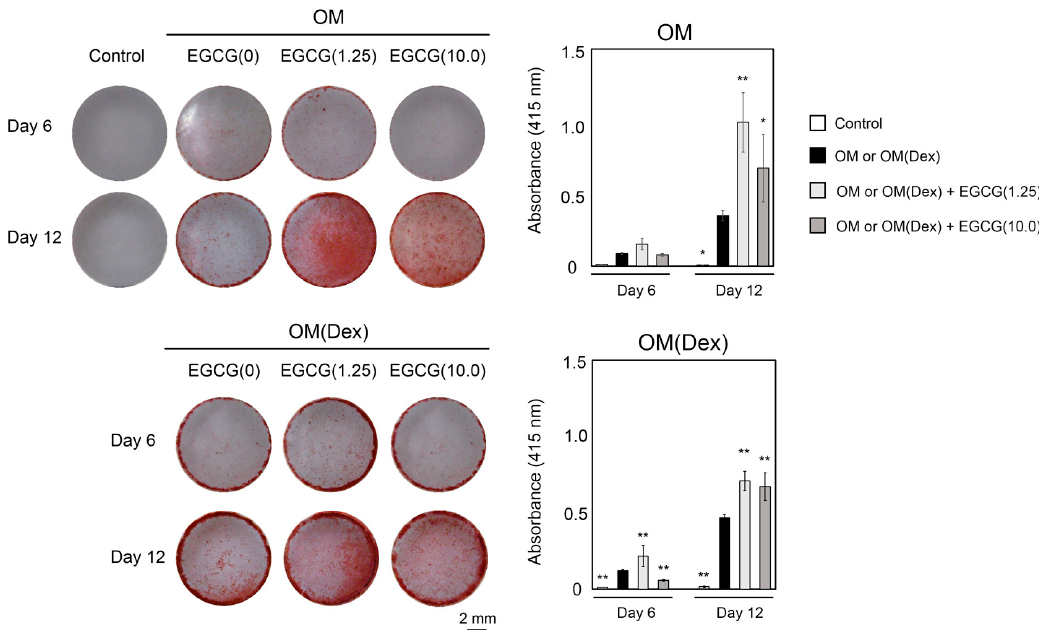
Figure 3. Alizarin red staining of DFAT cells treated with or without EGCG in two different osteogenic media and the corresponding quantitative data. OM: osteogenic medium without Dex; OM(Dex): OM with 100 nM Dex. The cells were treated under condition 2. N in EGCG(N): concentration of EGCG ( μ M). * p < 0.05, ** p < 0.01 (ANOVA with a Tukey-Kramer test) indicates a statistically significant difference against OM or OM(Dex). The bar graph shows the mean with standard deviation ( n = 4).